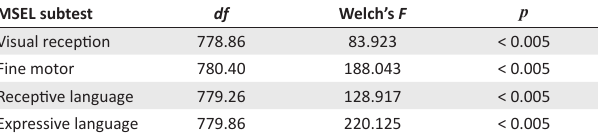
TABLE 9: One-way analysis of variance results for each Mullen Scales of Early Learning subtest by age group. MSEL subtest df Welch’s F